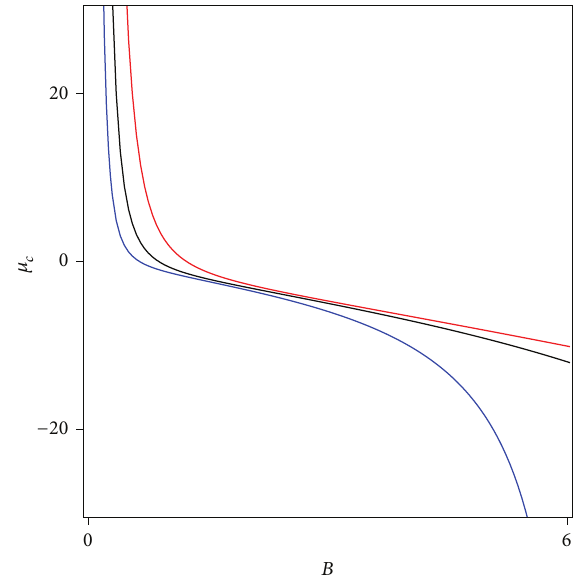
Figure 3: 𝜇 𝑐 in terms of 𝐵 for 𝑀 = 1 and 𝑙 = 1 ; 𝑎 = 1 (blue line), 𝑎 = 2 (black line), and 𝑎 = 4 (red